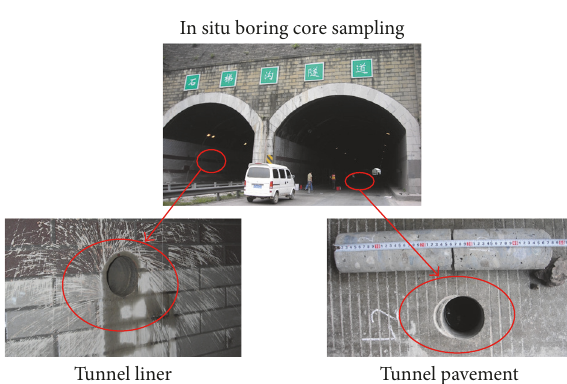
Figure 7: Detection point layout of the boring core sample.